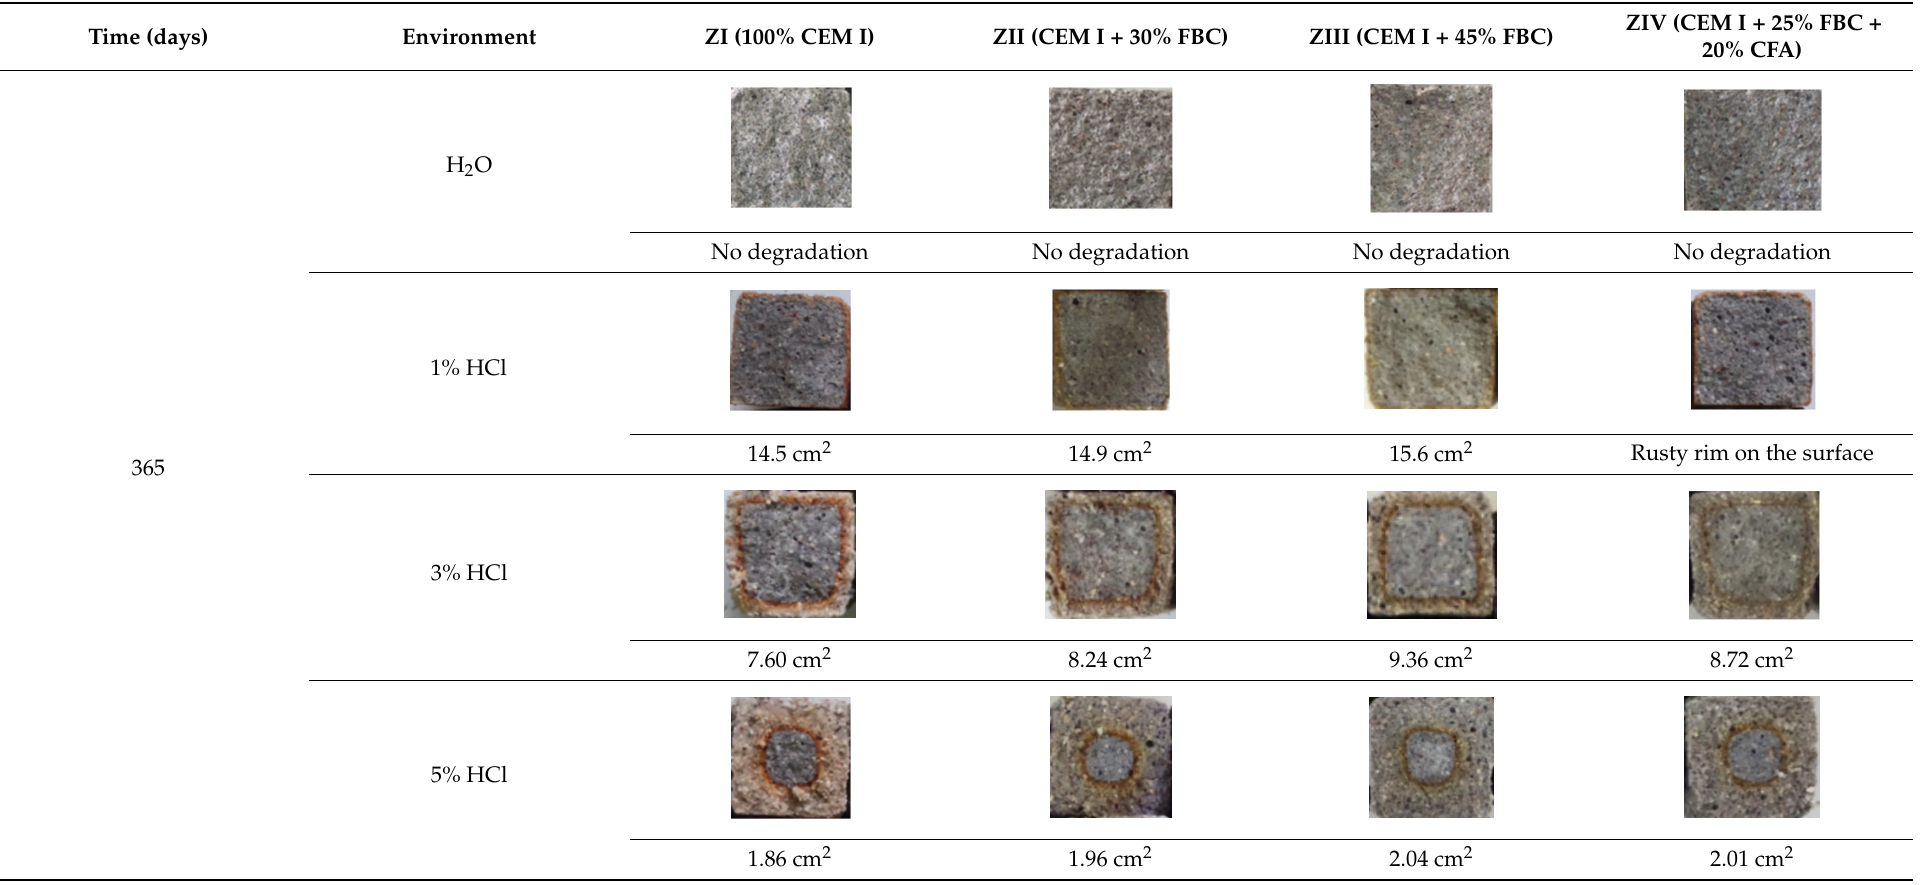
Table 9. Changes and cross-sectional area of mortars with FBC and CFA, exposed to aggressive